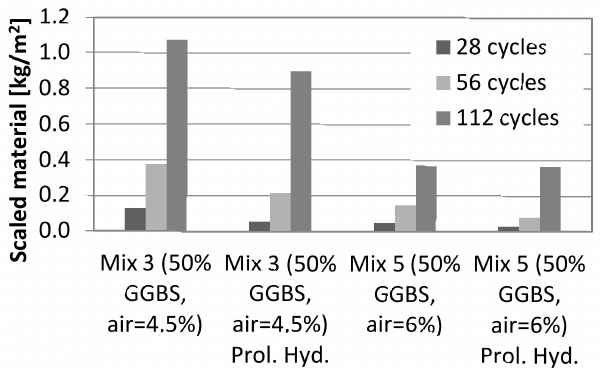
Figure 19. Comparison between the scaled material of Mixes 3 and 5, pre-conditioned according to the standard procedure and hydrated in the climate chamber during more 14